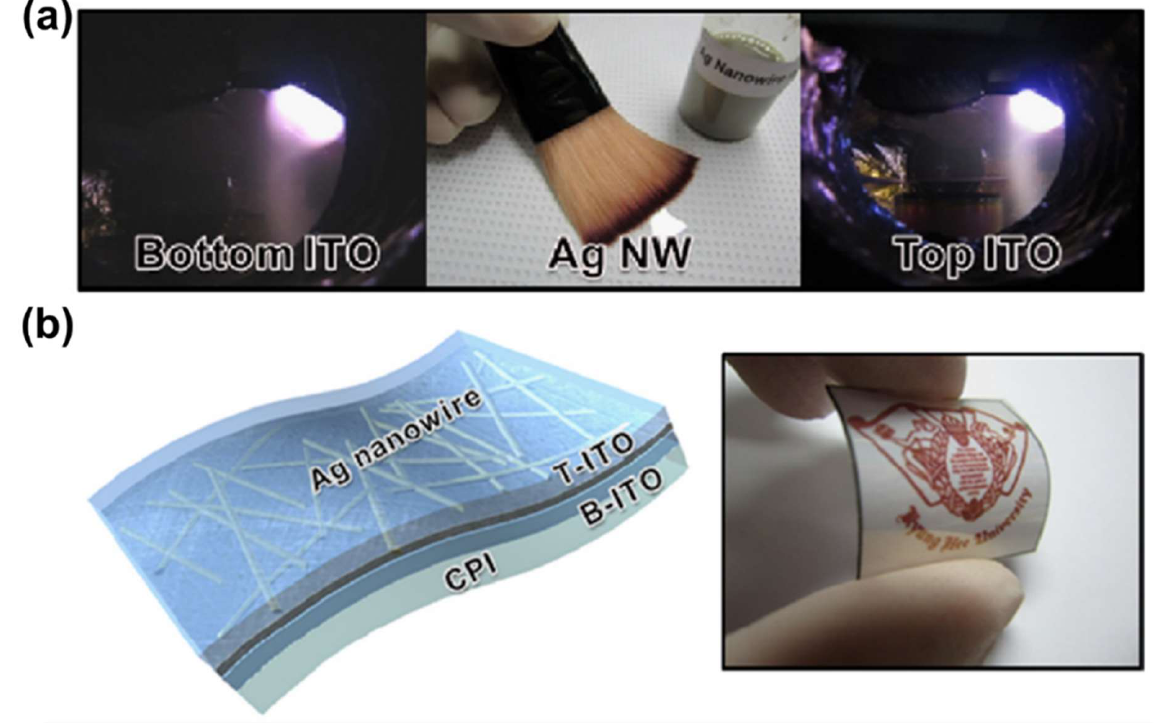
Figure 9. Schematic illustrations. ( a ) Fabrication of an ITO/Ag nanowire/ITO film generated by sputtering and simple brush painting. ( b ) Schematic and photograph of flexible ITO/AgNW/ITO on a flexible colorless polyimide substrate [182]. Copyright © 2021 Elsevier B.V. All rights reserved.